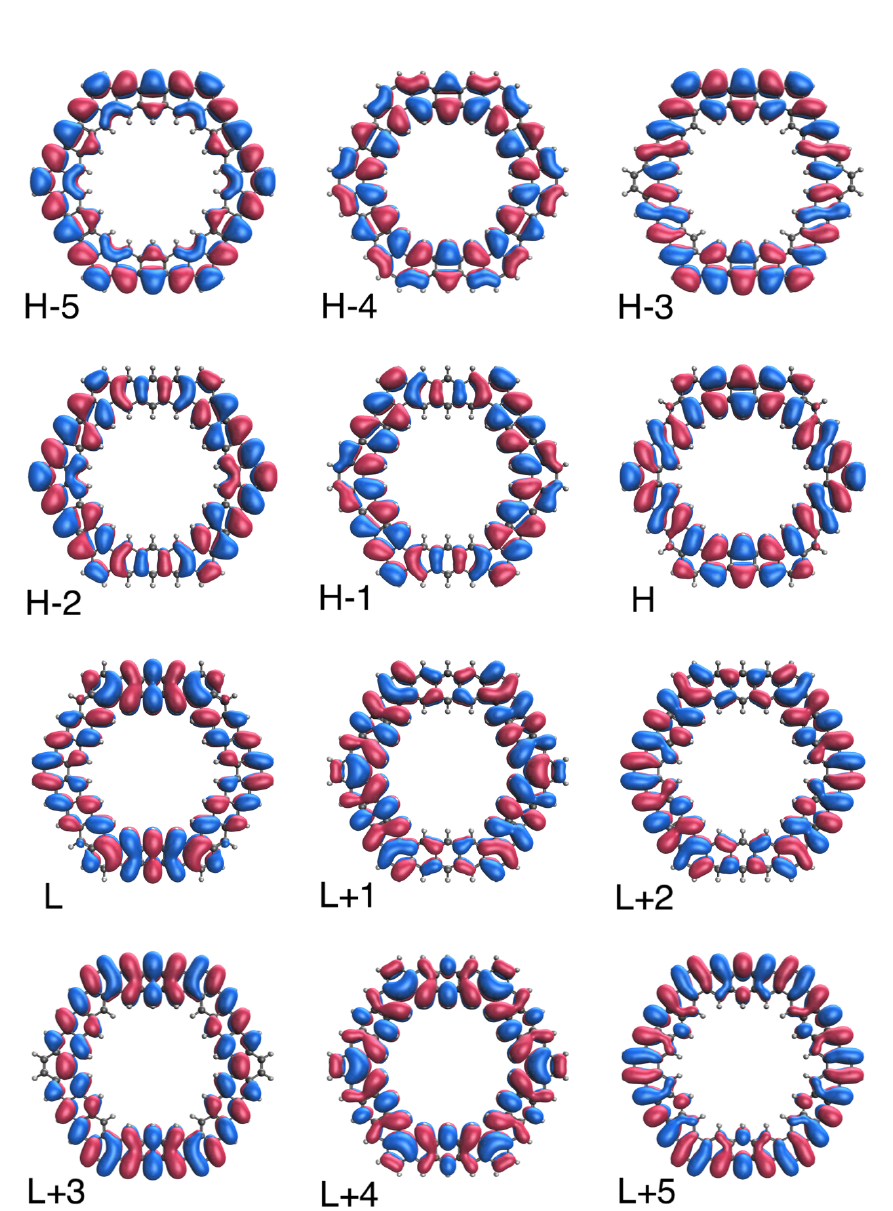
Figure 7. Real-space representation of active TAO-orbitals, such as H − 5 (1.987), H − 4 (1.983), H −